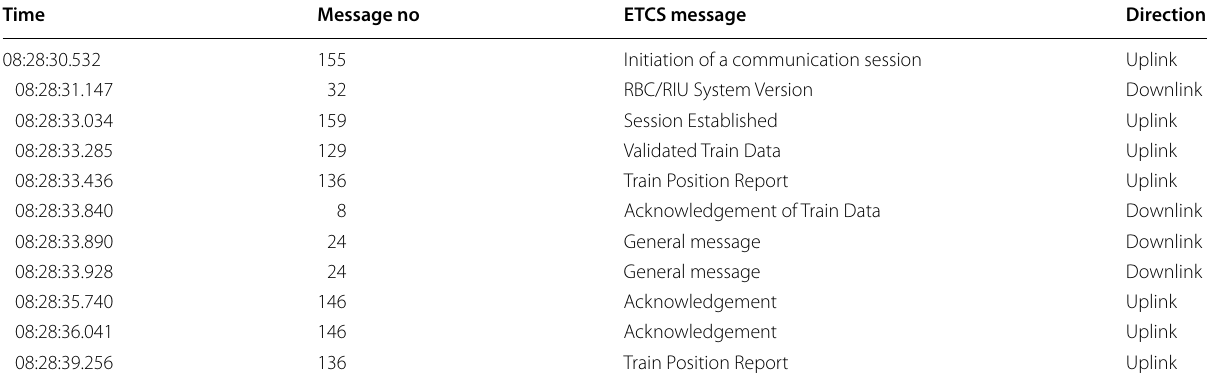
Table 1 Connection establishment signaling